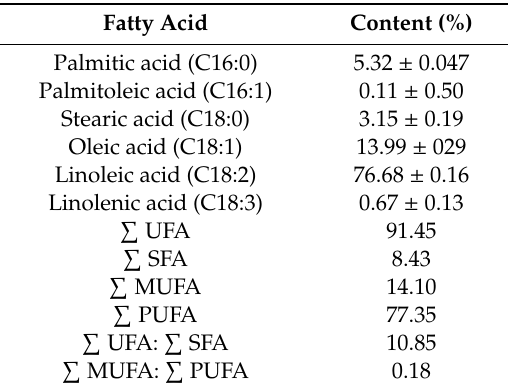
Table 2. Fatty acid composition of oil extracted from C. tinctoria seeds.